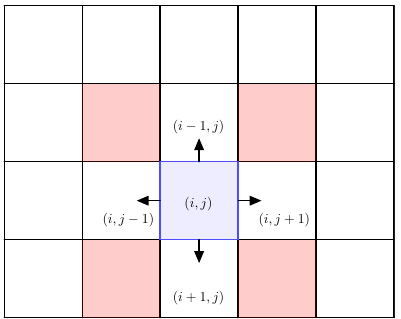
Figure 5. Example of potential neighbors for an arbitrary area unit (vertex).